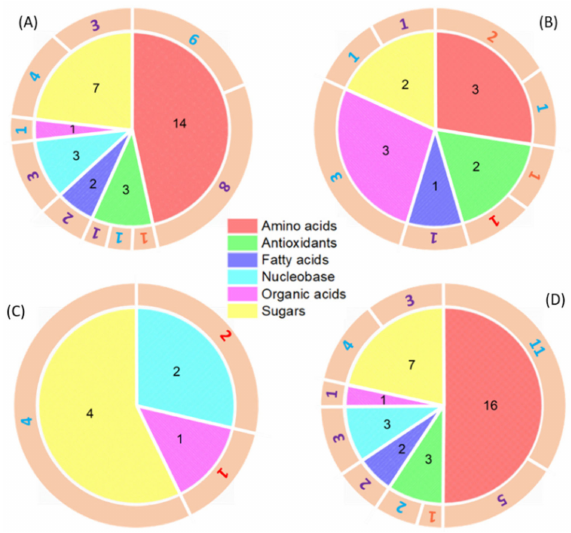
Figure 3. Comparison of significantly changed metabolites (/log2(fold change)/>1) in wheat leaves exposed to ( A ) Cu(OH) 2 NMs; ( B ) MoO 3 NMs; ( C ) Cu IONs; and ( D ) Mo IONs. Experimental conditions: SA—200 mg/L Triton TM X-100 solution; Cu(OH) 2 NMs—100 mg/L Cu(OH) 2 NMs (as Cu content) in SA; Cu IONs—0.1 mg/L CuSO 4 · 5H 2 O (as Cu content) in SA; MoO 3 NMs— 100 mg/L MoO 3 NMs (as Mo content) in SA; and Mo IONs—35 mg/L Na 2 MoO 4 2H 2 O (as Mo content) in SA. The numbers in the pie chart represent the significantly changed metabolites from each metabolite category. The color of the numbers in the outer circular ring indicates fold changes of the significantly dysregulated metabolites: red (fold change > 5), orange (2 < fold change < 5), blue (0.2 < fold change < 0.5), and purple (fold change < 0.2). Three replicates were used under each